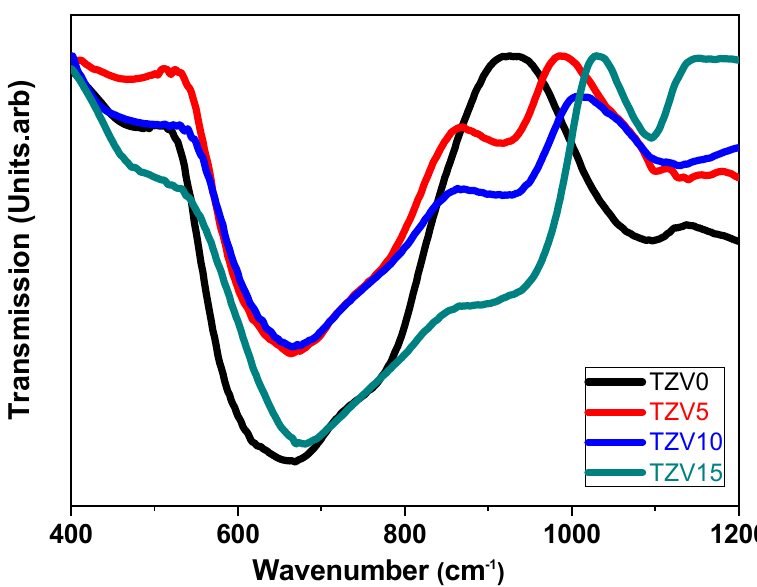
Figure 4. The FTIR spectra of the TZV glasses.